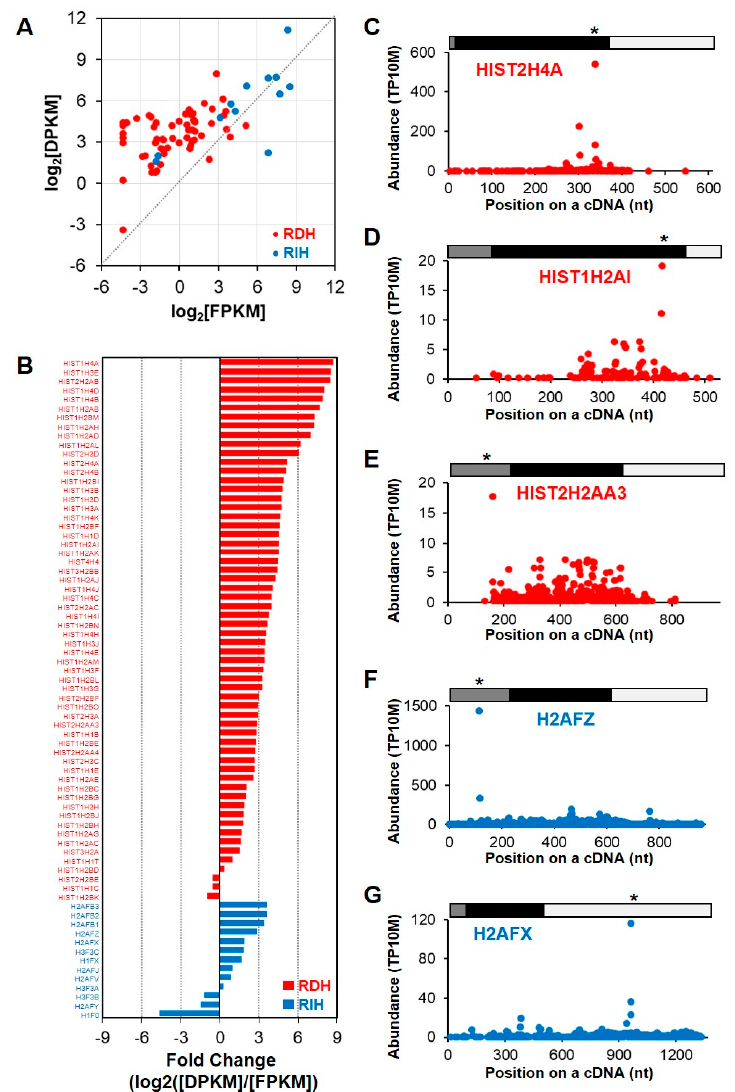
Figure 4. RNA stability of replication-dependent histone (RDH) mRNAs. ( A ) Scatter plot of relative expression levels according to RNA-seq (log2[FPKM]; X-axis) and degraded levels according to PARE-seq (log2[DPKM]; Y-axis). Red and blue dots indicate RDH and replication-independent histone (RIH) mRNAs, respectively; ( B ) relative fold change of RDH and RIH mRNA between expression levels according to RNA-seq data and degraded levels according to PARE-seq data; ( C – G ) and, selected D-plots of RDH and RIH mRNA. The normalized abundances of PARE sequences were plotted on the annotated cDNA positions. Grey, black, and white bars indicate 5 ′ untranslated region (UTR), coding region, and 3 ′ UTR, respectively. Star indicates the position of the most abundance PARE sequence. *p < 0.05